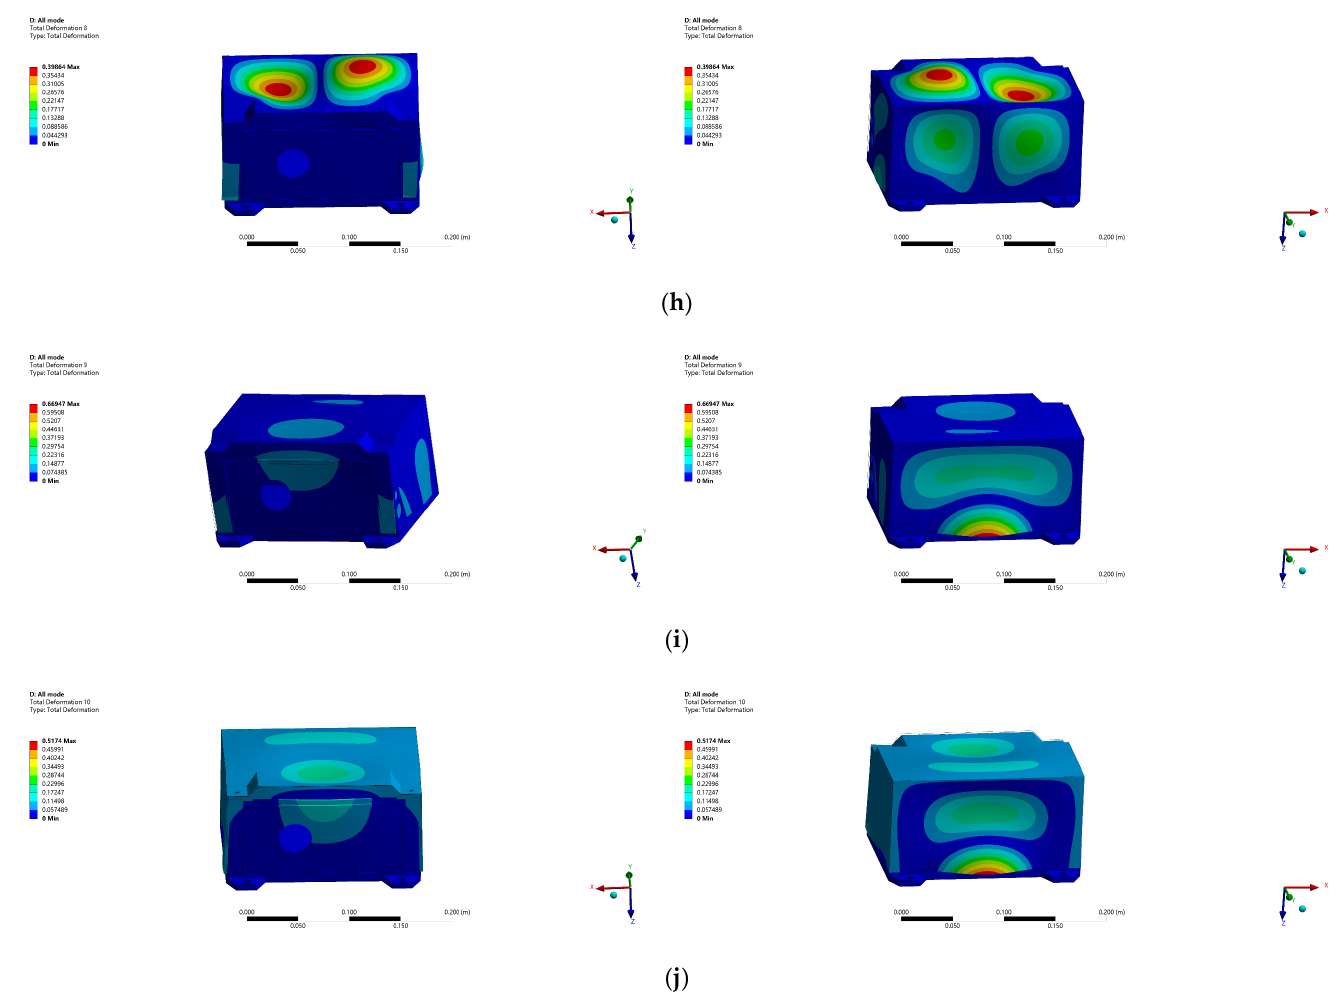
Figure 7. The first 10 order modes of the electrical control box. ( a – j ): 1 to 10 mode.